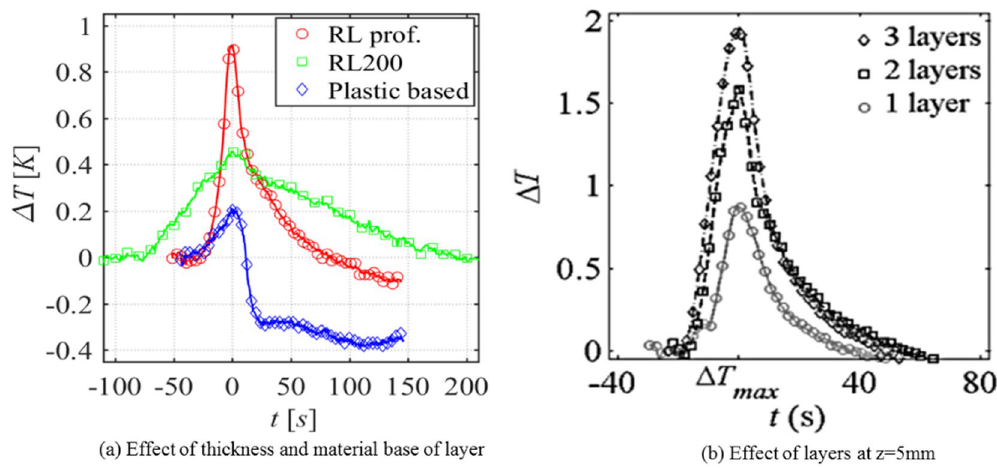
Figure 20. Effect of thickness and paper type on temperature